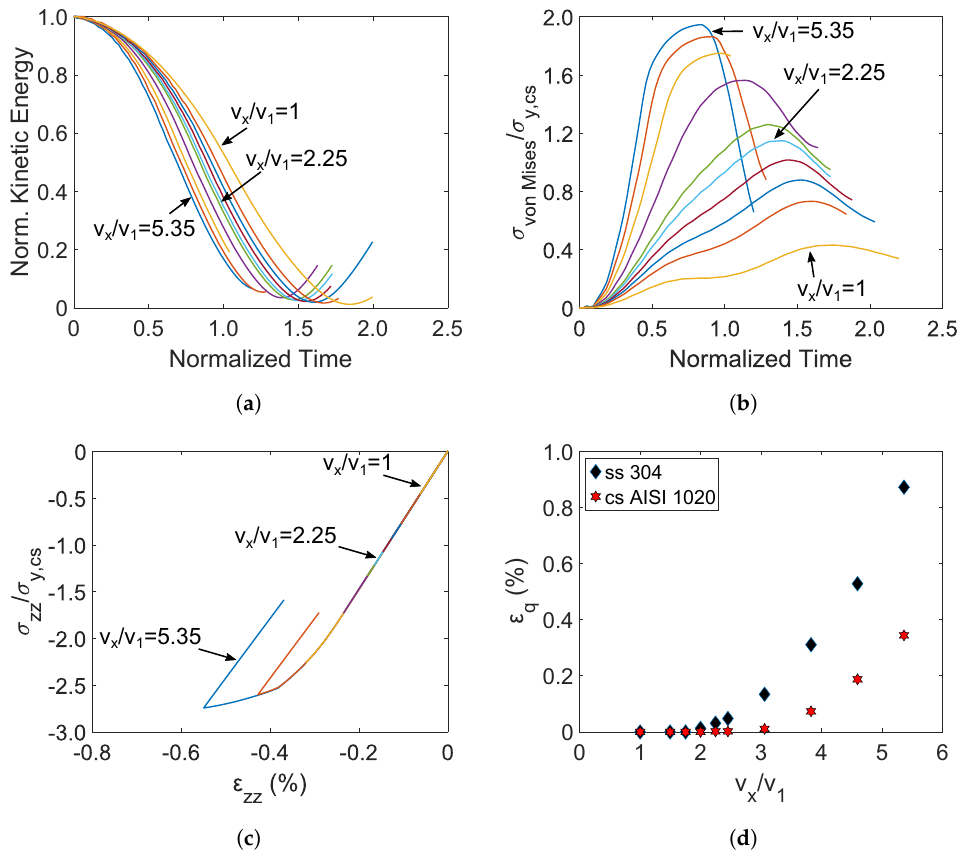
Figure 8. ( a ) Normalized kinetic energy with respect normalized time, ( b ) normalized von Mises stress with respect normalized time at the trailing edge of the foil profile at fixed end, ( c ) normalized normal stress at z -direction with respect the strain at the trailing edge of the foil profile at fixed end, ( d ) equivalent plastic strain, for the different velocities of the killer whale; carbon steel material of Grade AISI 1020